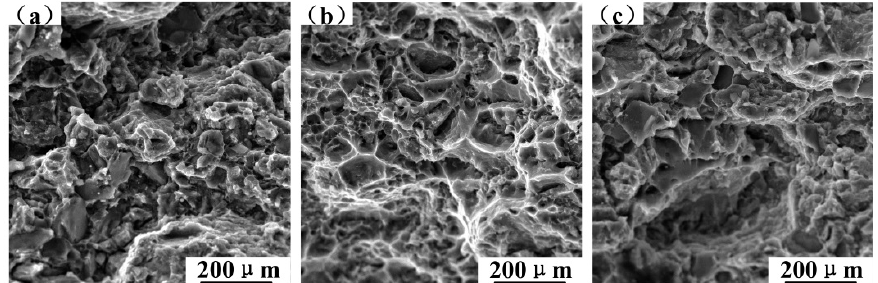
Figure 13. The fracture morphology for tensile temperature: ( a ) T6-treated 30%SiC/6061 at room temperature, ( b ) T6-treated 30%SiC/6061 at 100 °C, and ( c ) T6-treated 30%SiC/6061 at 200 °C.